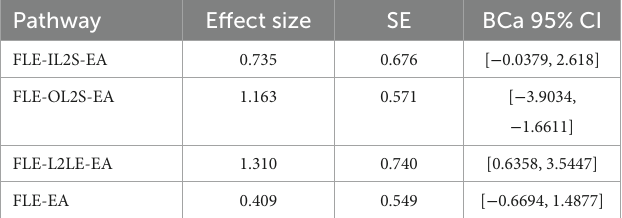
TABLE 5 Effect size and significance of each path.